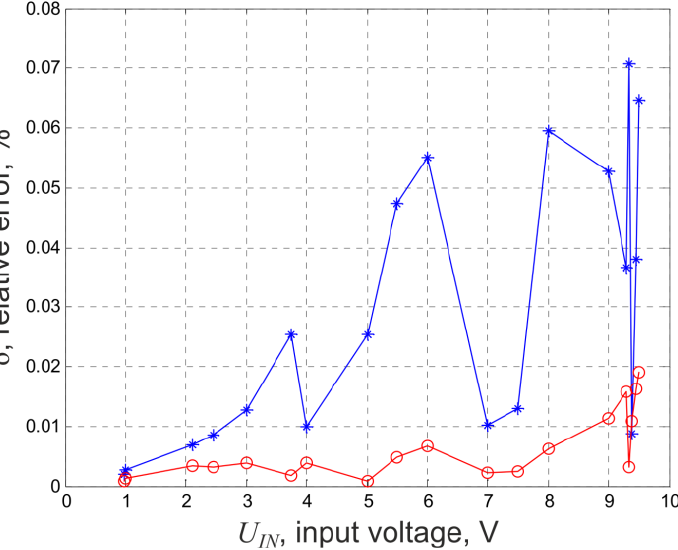
Figure 4. Graphs of the processing error of the multifunctional ADCF converter: 10-bit (blue *) and 12-bit (red o), for five input voltages.